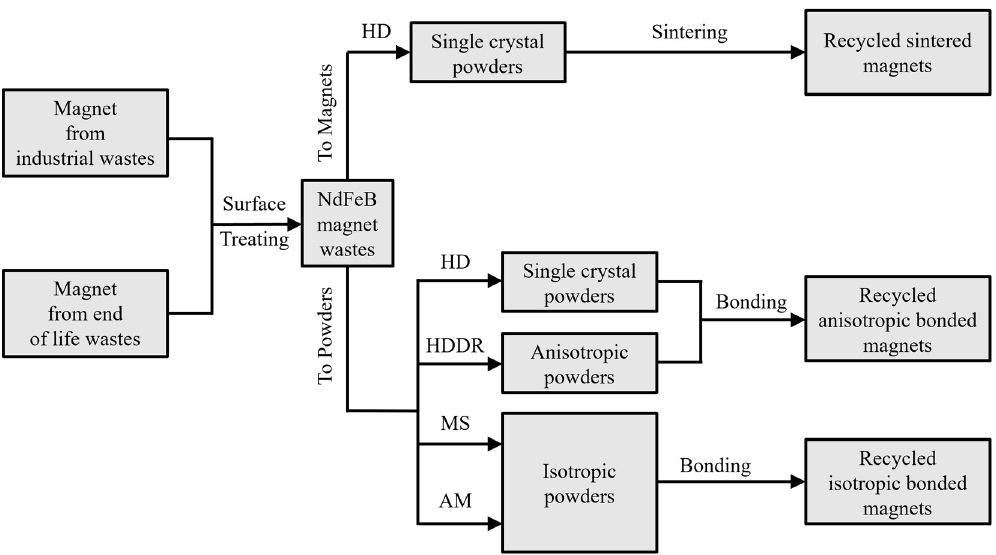
Figure 3. Flow chart of main techniques for direct reuse of NdFeB magnet wastes.